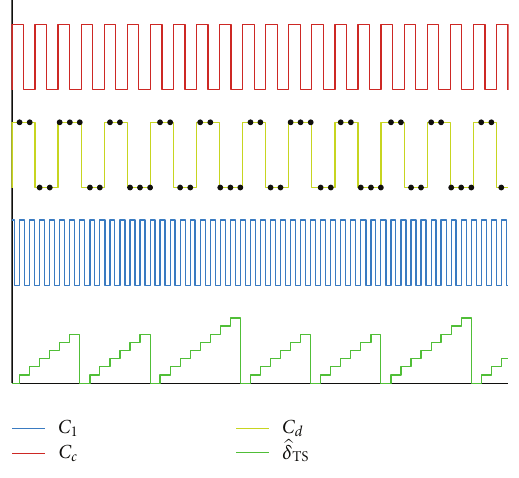
Figure 5: Phase estimation between cycle